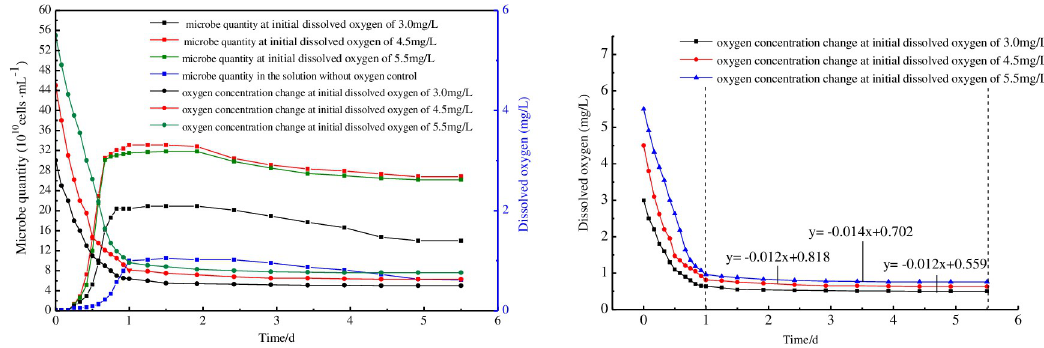
Fig 8. Strains growth and oxygen concentration change under different initial dissolved oxygen condition.